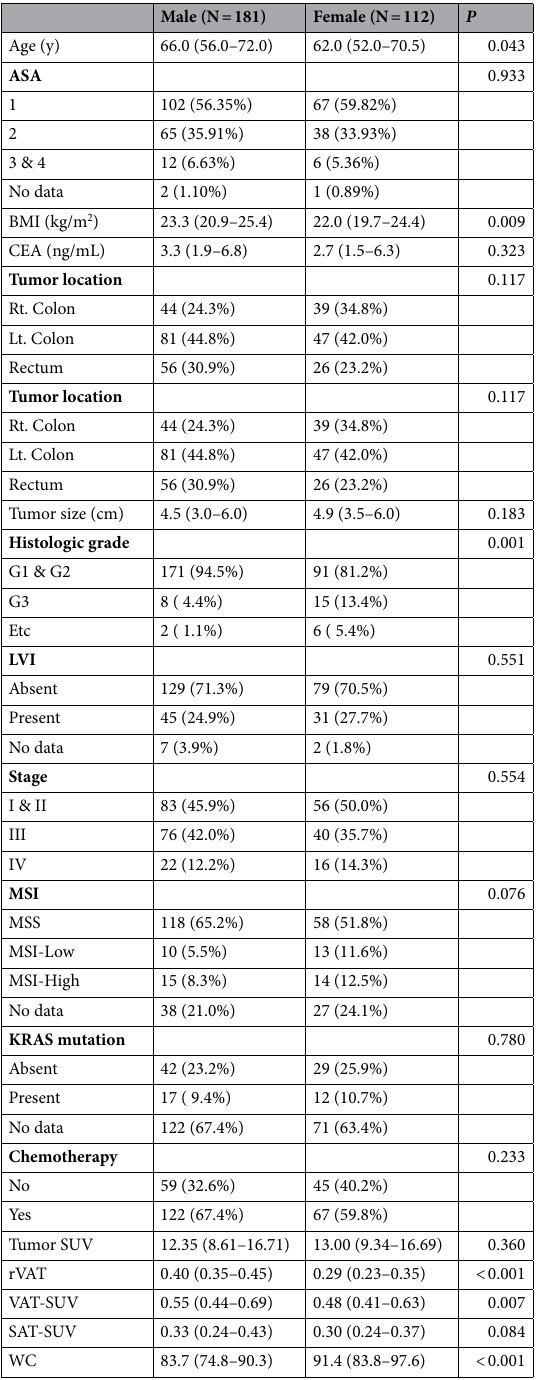
Table 1. Patients demographics. Data are presented as numbers with percentages or median with interquartile ranges. ASA = American society of anesthesiology, BMI = Body mass index, CEA = Carcinoembryonic antigen, LVI = Lymphovascular invasion, MSI = Microsatellite instability, MSS = Microsatellite Stable, SUV = Standardized uptake value, rVAT = volume ratio of visceral adipose tissue (VAT) to total adipose tissue, SAT = subcutaneous adipose tissue, WC = waist